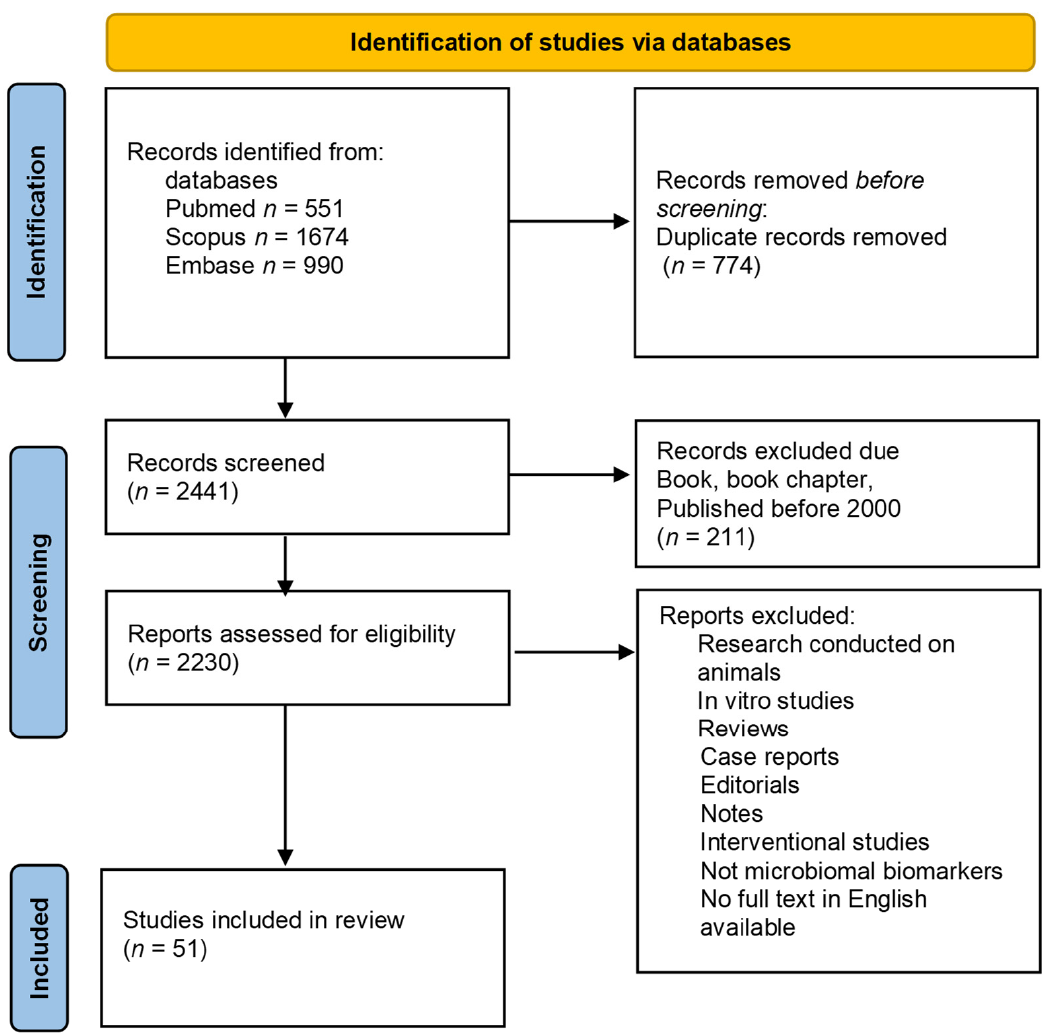
Figure 1. PRISMA flowchart in accordance with the PRISMA 2020 statement. ( n —number)